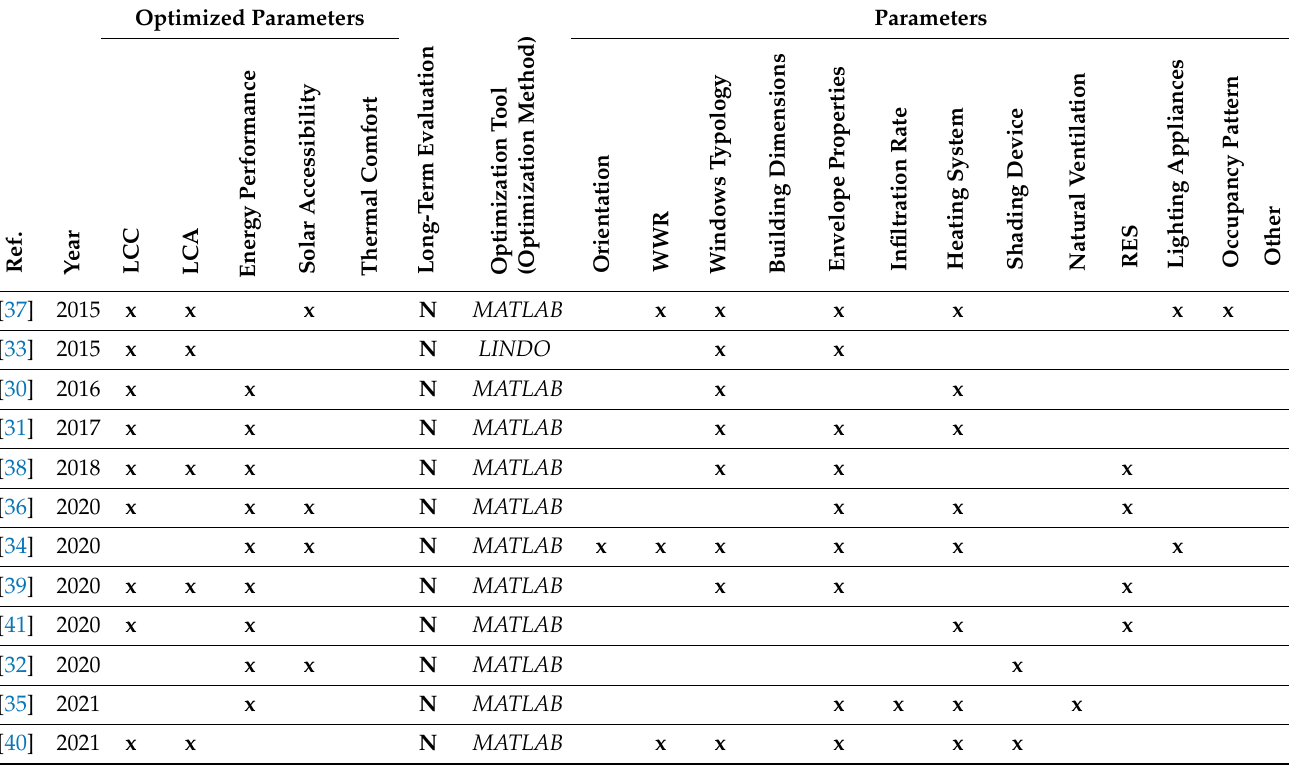
Table 4. Tabular review of journal articles about MATLAB-based MOO